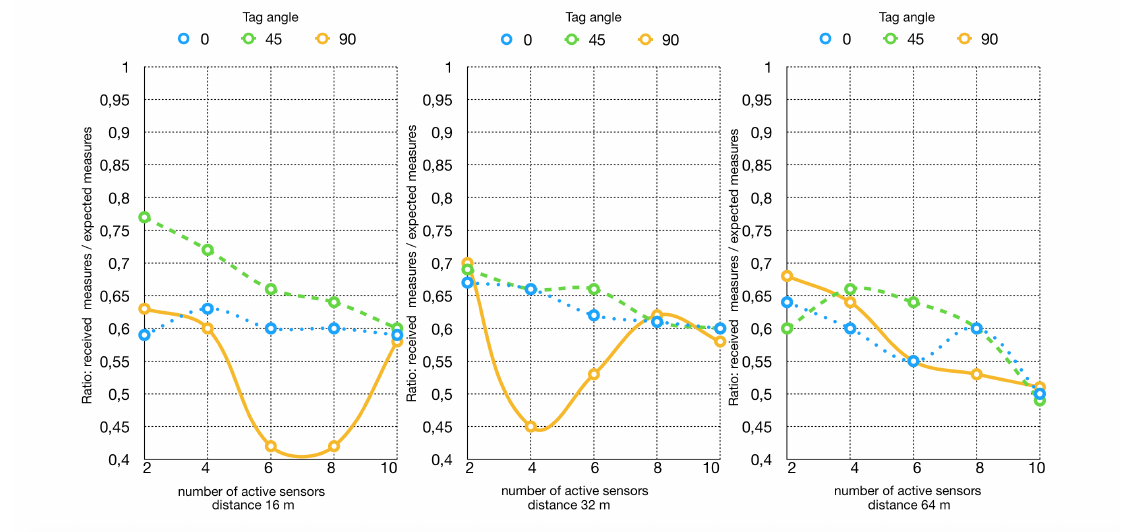
Figure 3. RFID reception rate taking into account tag